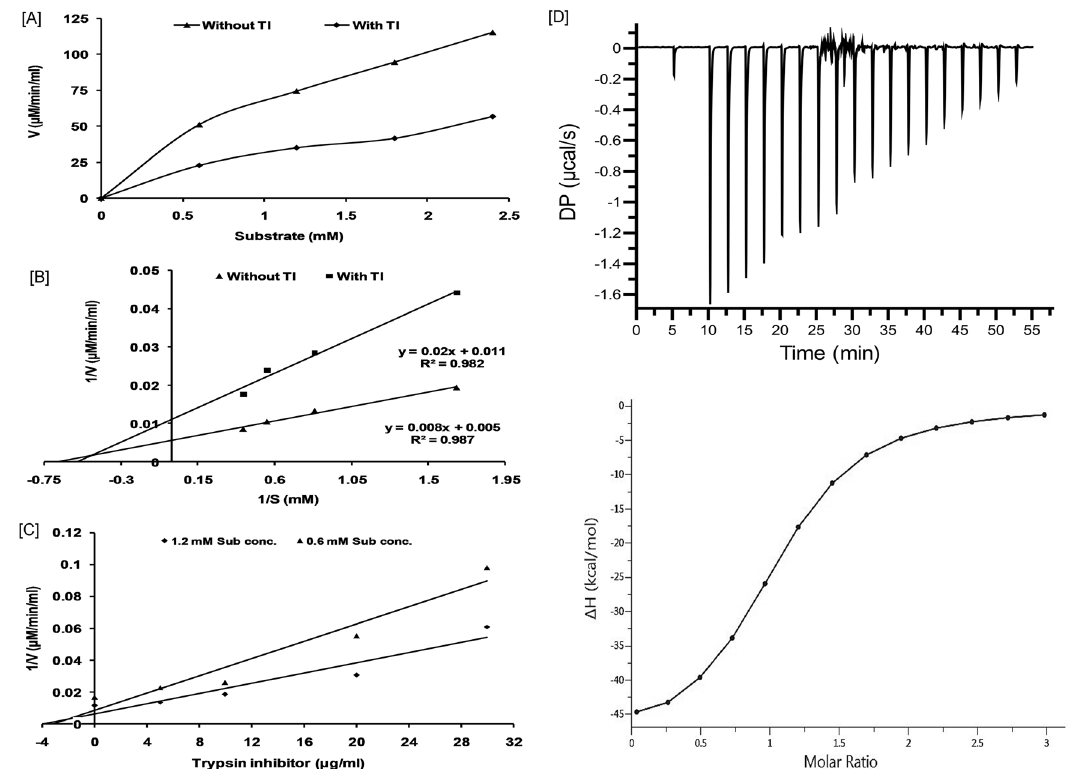
Figure 5. Kinetic analysis of purified SSTI. Noncompetitive (mixed) type of inhibition of bovine trypsin ( A ) Michaelis–Menten kinetics of bovine trypsin in presence and in absence of SSTI. ( B ) Lineweaver–Burk plot of 1/[V] versus 1/[S] of bovine trypsin in presence and in absence of SSTI. (C) Dixon’s plot of 1/[V] versus [I] of bovine trypsin in presence of different concentrations of SSTI at two different concentrations of BApNA. The Ki value for SSTI was 16.6 × 10 −8 M. (D) Interaction by Isothermal titration of purified SSTI with bovine